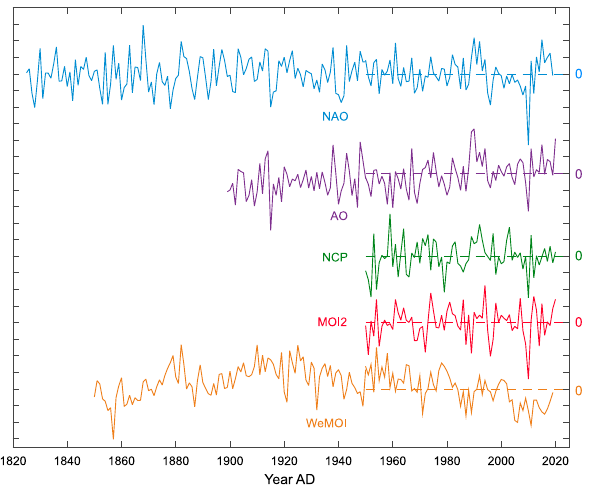
Figure 2. Time Series of NAO (blue), AO (purple), NCP (green), MOI2 (red), and WeMOI (orange) index over the respective available period. Shown are mean annual values with a step size of 0.5. The horizontal dashed lines mark index zero across the study period